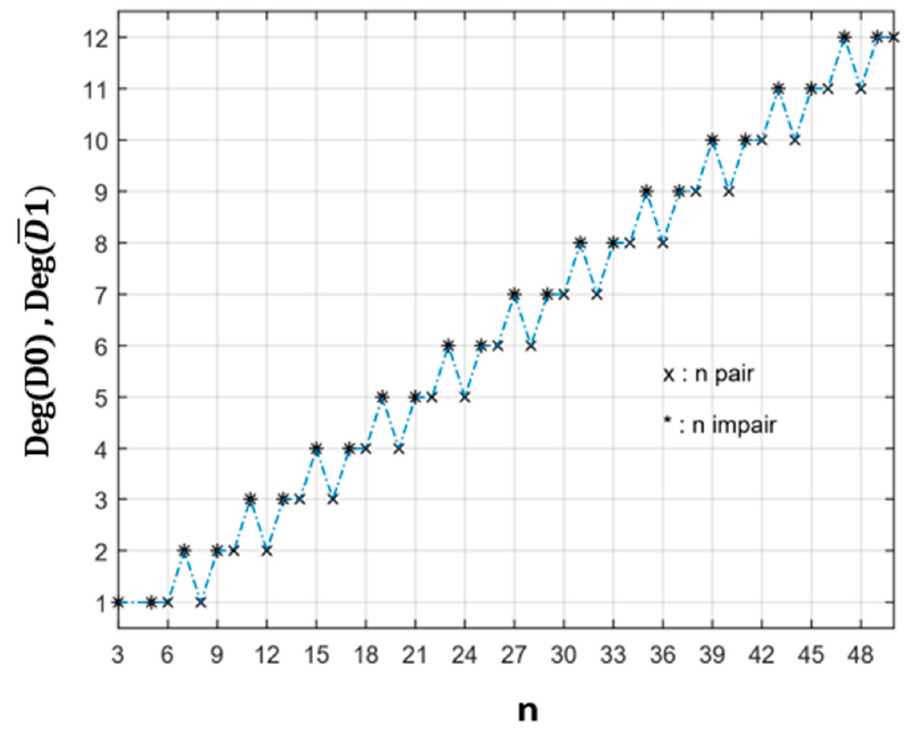
Figure 8. Variation of degree of degeneracy deg(D 0 ) and deg( D 1 ) with Figure 7. Variation of degree of degeneracy deg(D 0 ) and deg( 𝐷(cid:3365) 1 ) with n.